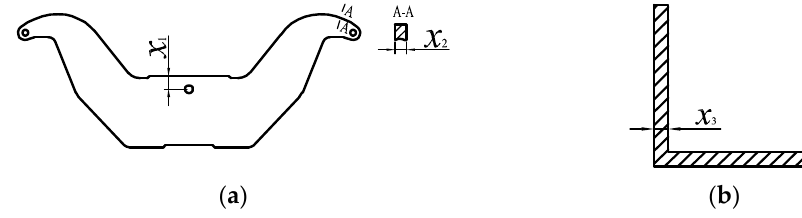
Figure 8. Important dimensional parameters of split drape coupling plate. ( a ) Top coupling plate hole distance and small coupling plate thickness. ( b ) Equilateral angle thickness.